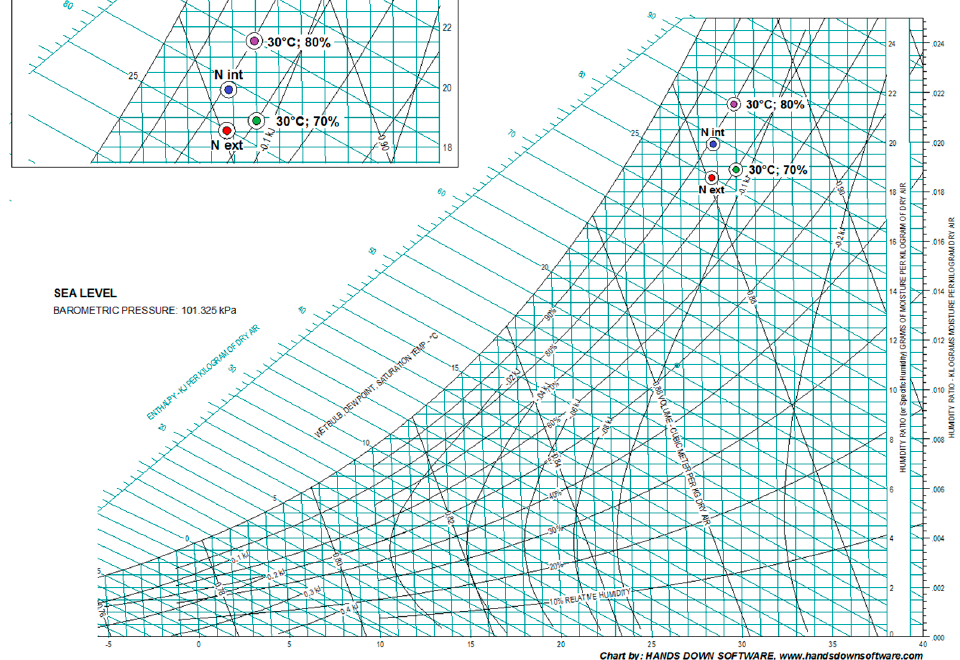
Figure 3. Nominal Figure 3. Nominal points.